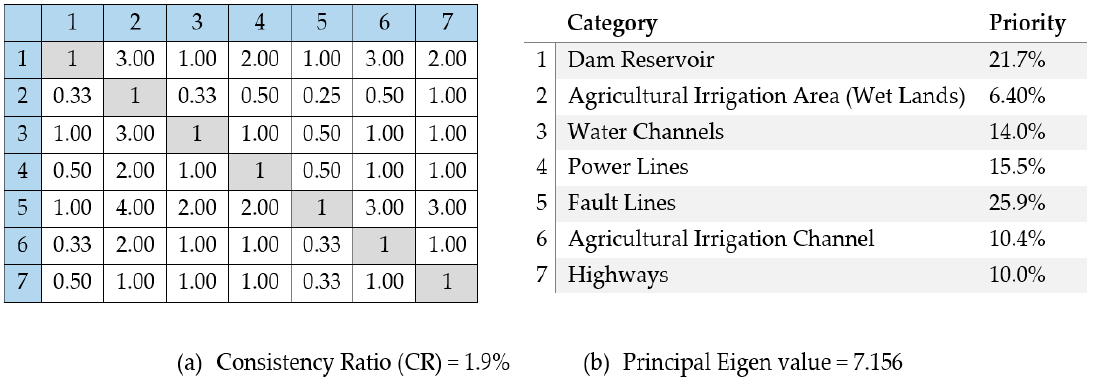
Figure 10. Constraints obstacles weights and scores [32].